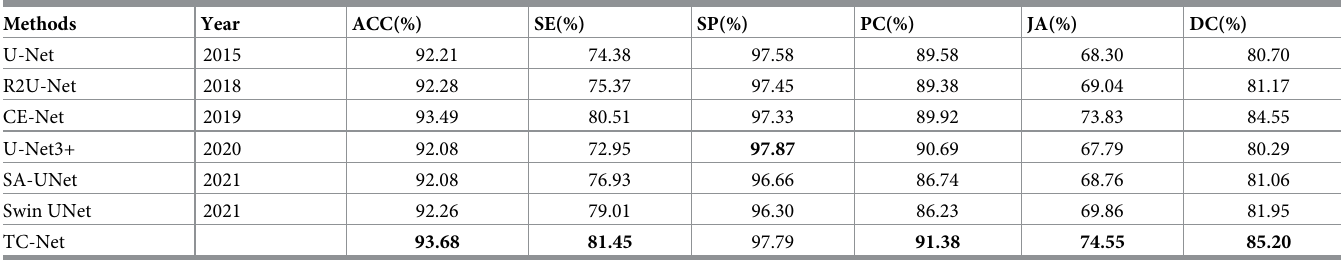
Table 5. Comparative experiments based on ISBI2017 dataset. Methods